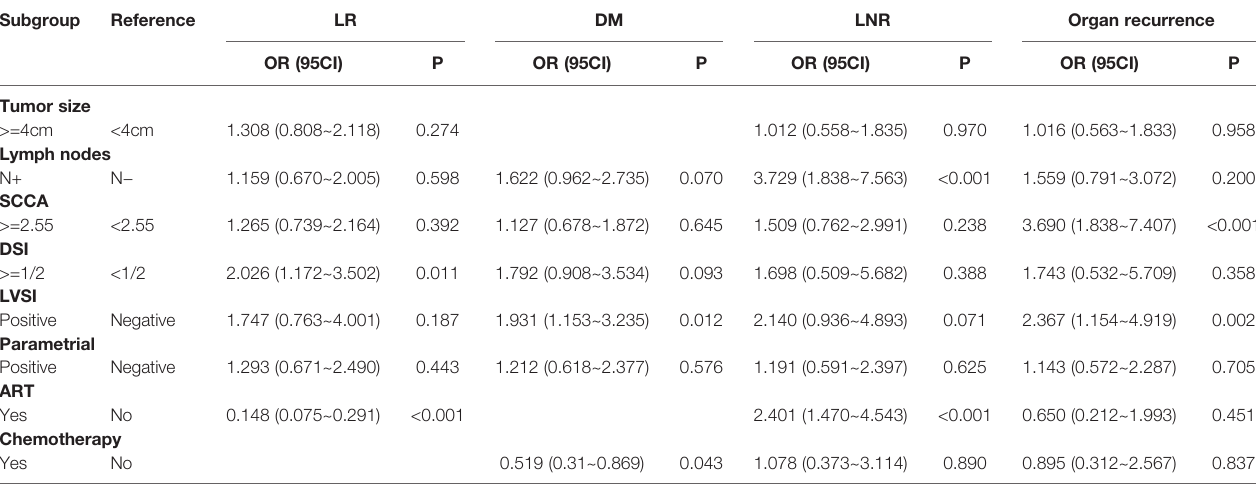
TABLE 3 | Multivariate logistic regression models for different recurrence sites and subtypes.